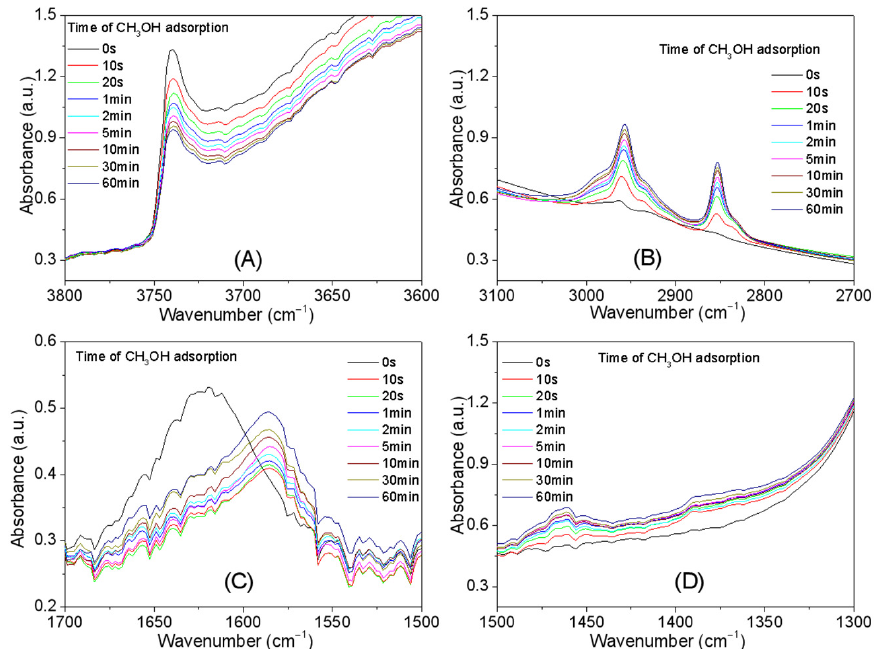
Figure 2. In situ FTIR spectra of CH 3 OH adsorption on Zr/SBA-15 catalyst in the regions of 3600 cm − 1 –3800 cm − 1 ( A ), in situ FTIR spectra of CH 3 OH adsorption on Zr/SBA-15 catalyst in the regions of 2700 cm − 1 –3100 cm − 1 ( B ), in situ FTIR spectra of CH 3 OH adsorption on Zr/SBA-15 catalyst in the regions of 1500 cm − 1 –1700 cm − 1 ( C ), in situ FTIR spectra of CH 3 OH adsorption on Zr/SBA-15 catalyst in the regions of 1300 cm − 1 –1500 cm − 1 ( D ).